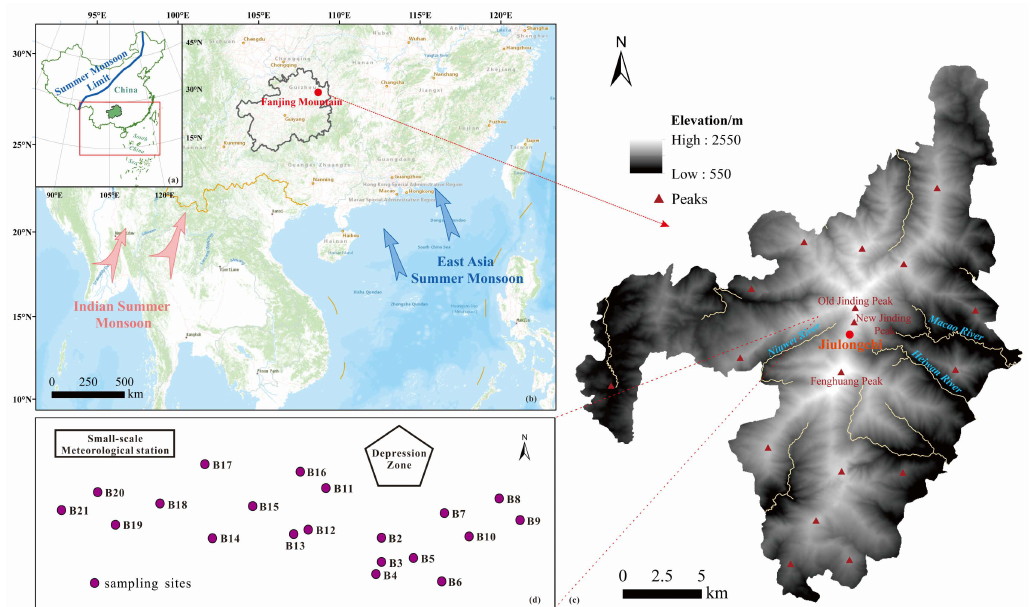
Figure 1. The location of Guizhou Province in China ( a ), Fanjing Mountain in Guizhou Province ( b ), elevation map of Fanjing Mountain ( c ) and the sketch map of sampling sites ( d ).